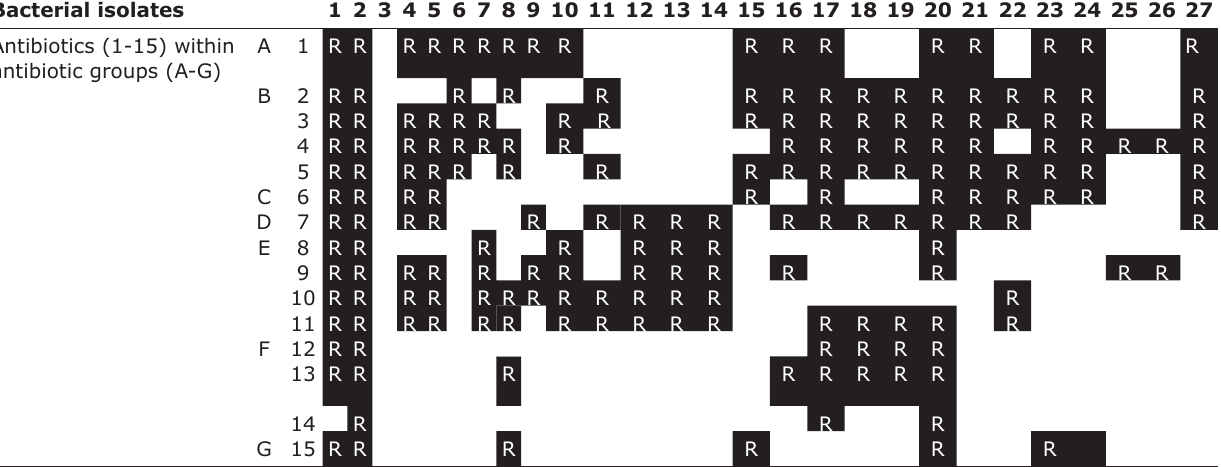
Table-4: Determination of multidrug-resistant isolates using in vitro sensitivity. Bacterial isolates Antibiotics (1-15) within antibiotic groups